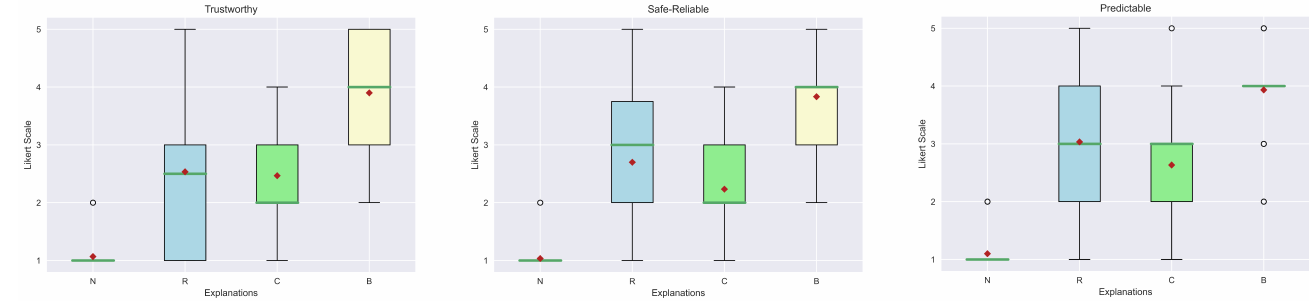
Figure 19. Box plot of the trust qualities of the explanations for the “Why”